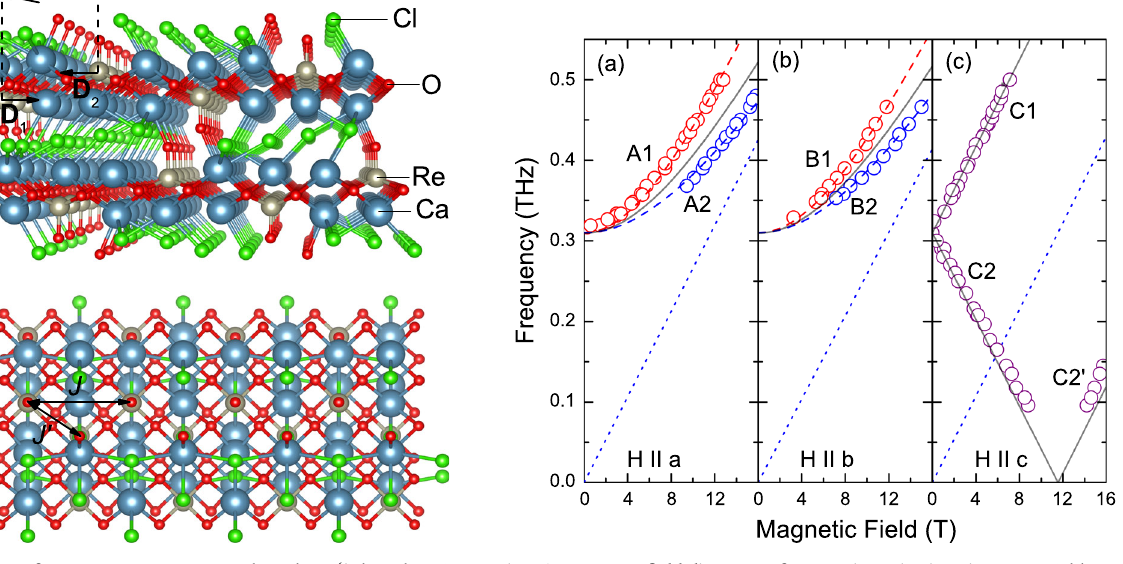
Fig.1|CrystalstructureofCROC.a PerspectiveviewalongtheRe 6+ chaindirection ( b axis). Ca atoms are shown in blue, Re in gray, O in red, and Cl in green. J and J 0 are intra- and interchain exchange interactions, respectively. The DMI vectors from adjacent chains ( D 1 and D 2 ) are schematically shown by arrows (see thetextfordetails). b ParallelviewofthecrystalstructureofCROCalongthe a axis.